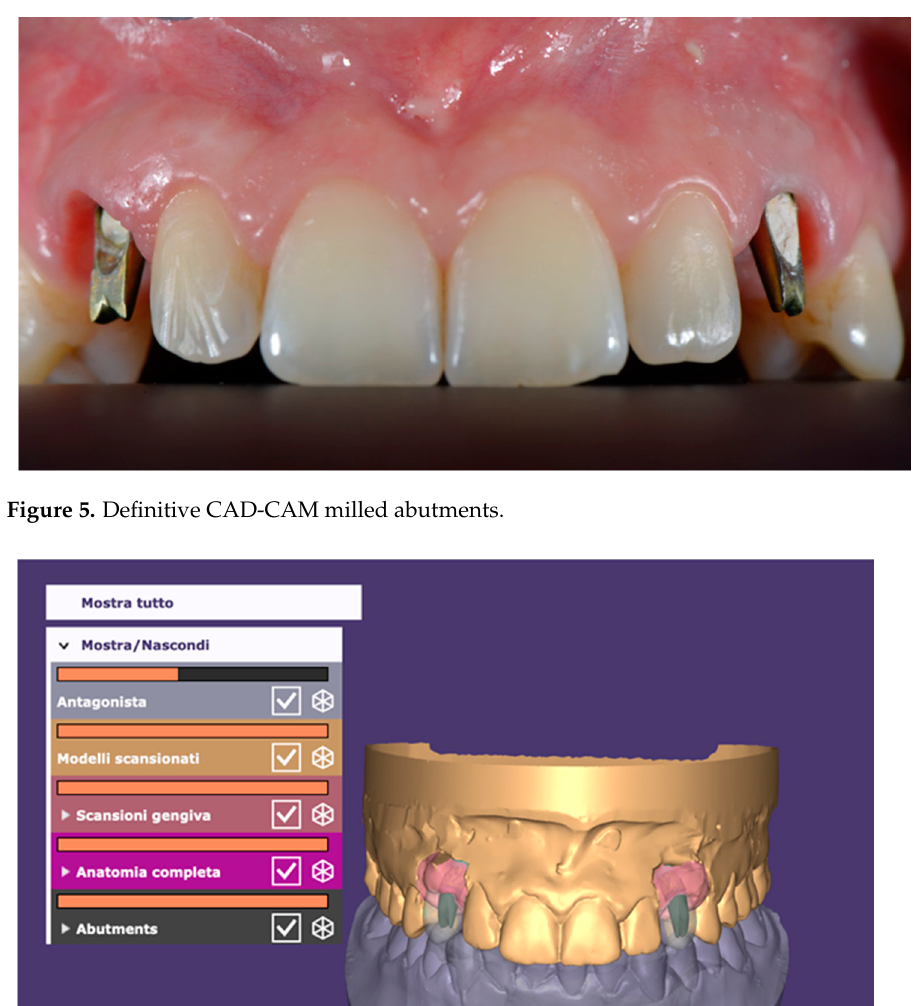
Figure 5. Definitive CAD-CAM milled abutments.